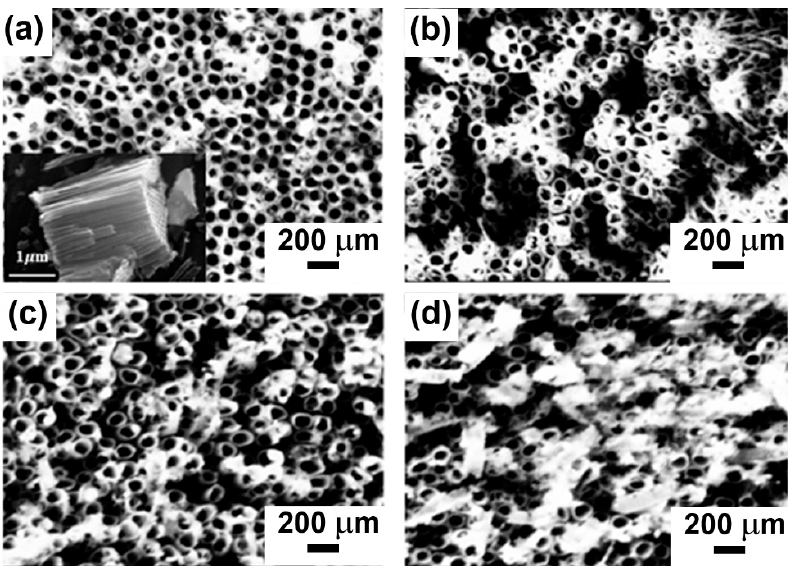
Figure 1. FESEM micrographs of ( a ) TiO 2 NTs, ( b ) TiO 2 NTs/Ag-0.1 M, ( c ) TiO 2 NTs/Ag-0.5 M and ( d ) TiO 2 NTs/Ag-1.0 M. Inset in ( a ): the cross-section SEM image showing the length of TiO 2 NTs.